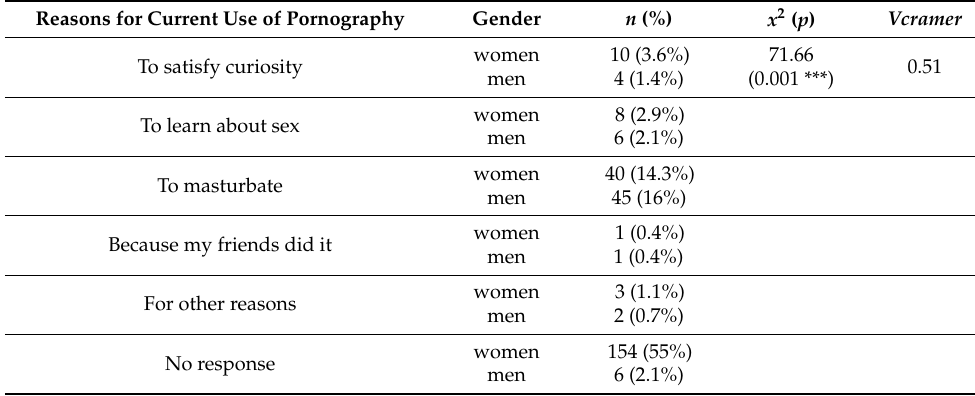
Table 1. Reasons for Currently Watching Pornography according to